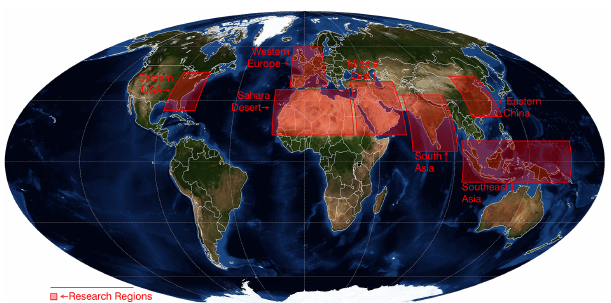
Figure 4. Regions used in this